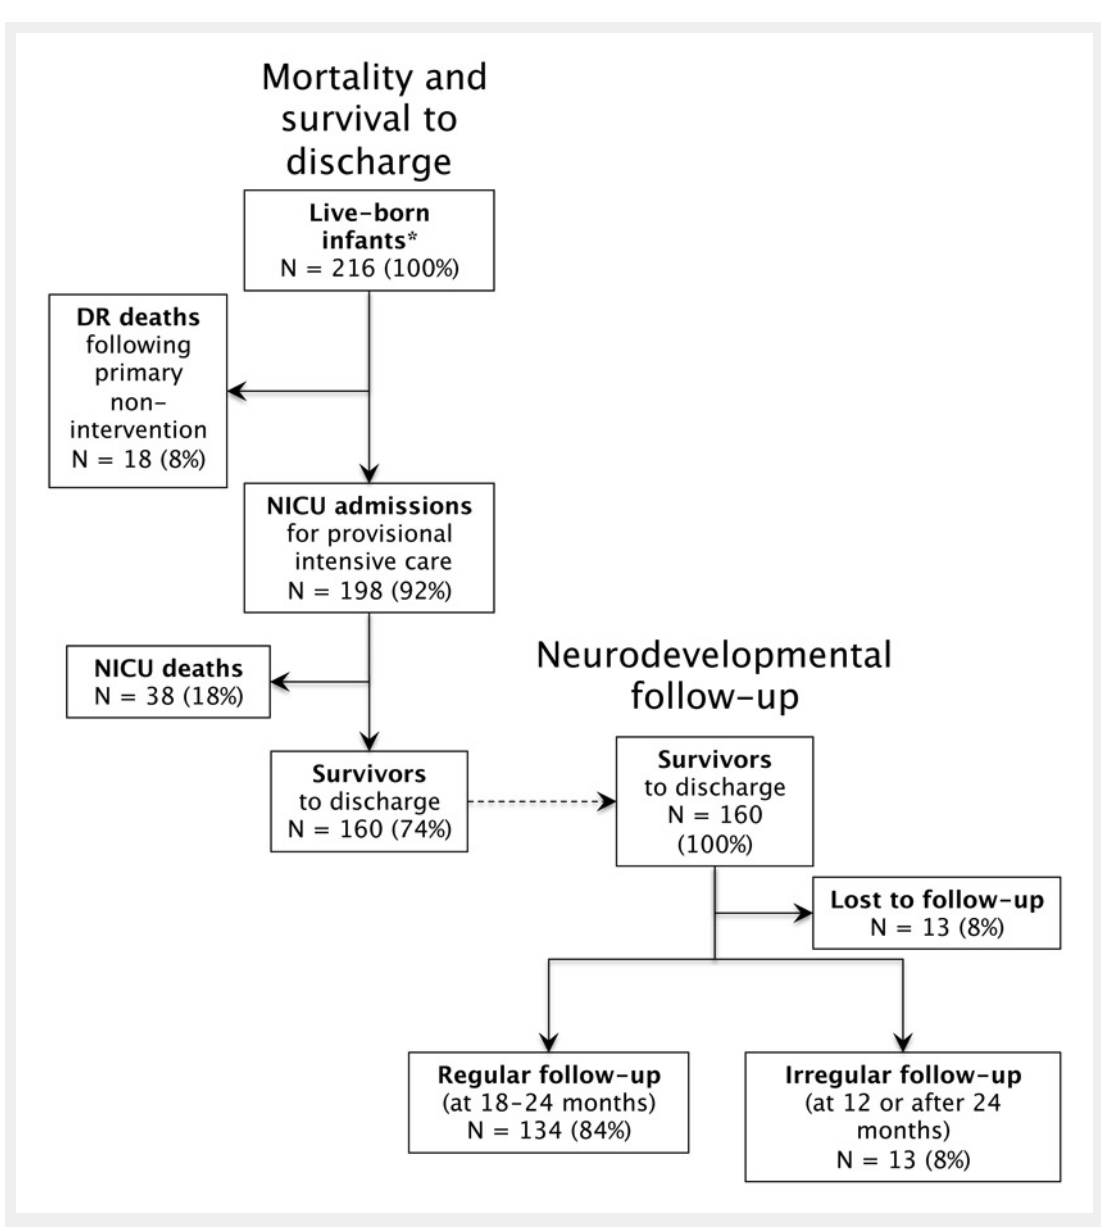
Figure 1 ELGAN patient population cared for at the Children's Hospital of Lucerne between 2000 and 2009: DR and NICU mortality, survival and neuro- developmental follow-up rates. * After exclusion of one ELGAN with trisomy